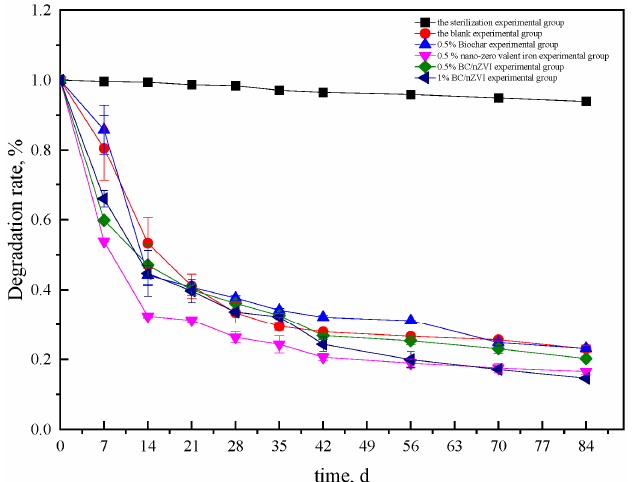
Figure 5. Effects of different experimental treatments on the degradation of γ -HCH. Table 2. Multiple comparison of degradation rates on α -HCH and γ -HCH by different materials.